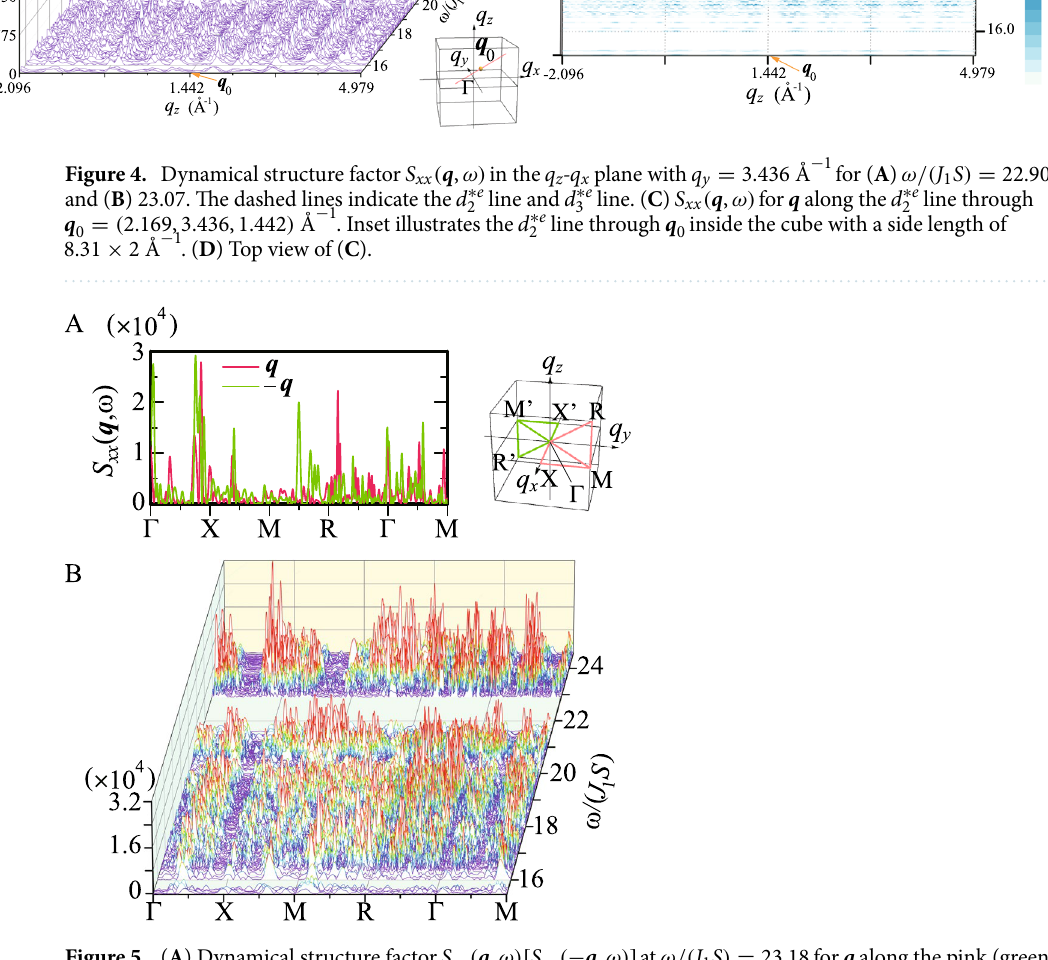
Figure 5. ( A ) Dynamical structure factor S xx ( q , ω) lines in the inset. Inset illustrates the cube with a side length of 2.56 along the pink lines in the inset and for ω N